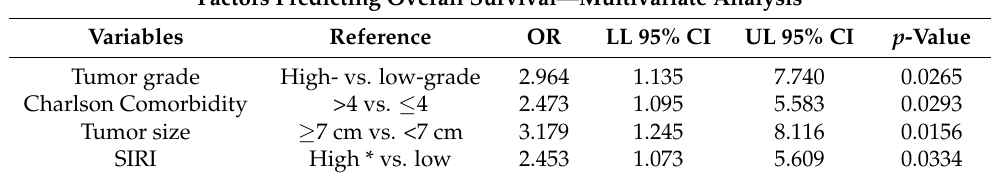
Table 5. Multivariate analyses of factors predictive for overall survival in patients with clear cell renal cell carcinoma (ccRCC). Factors Predicting Overall Survival—Multivariate Analysis